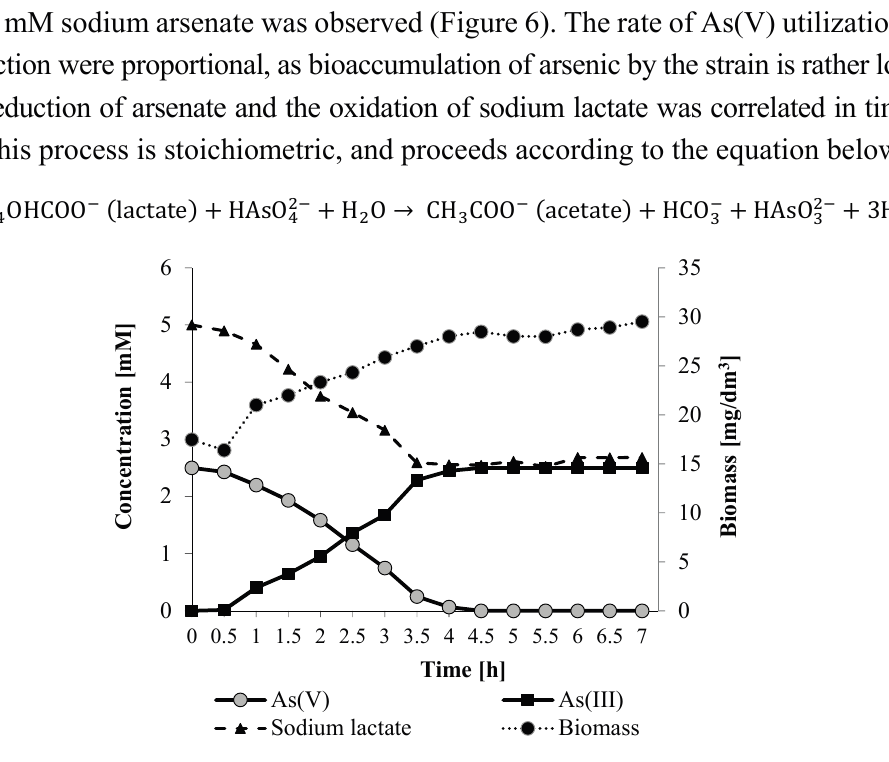
Figure 6. Arsenate reduction mediated by Shewanella sp. O23S under anaerobic conditions at 22 °C, pH 8 in minimal salt medium supplemented with 2.5 mM sodium arsenate and 5 mM sodium lactate. SD <